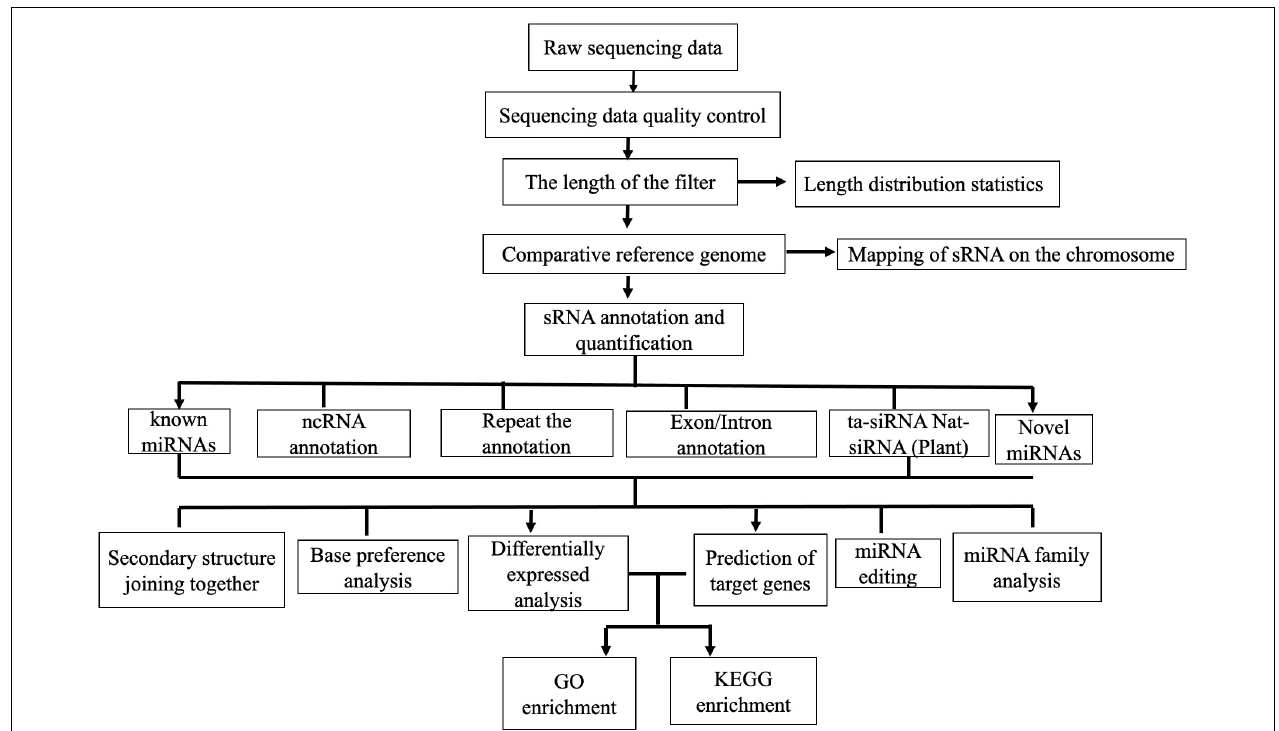
FIGURE 1 | Parametric analysis process of animal small